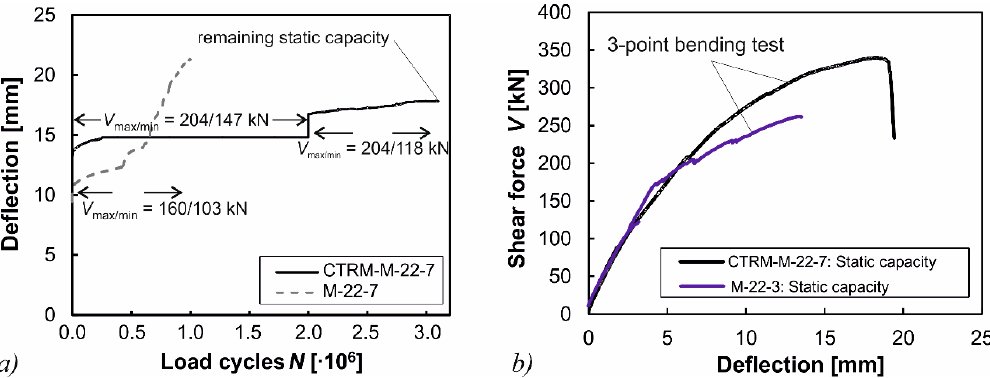
Figure 13. ( a ) Comparison of vertical deflections under cyclic loading for tests with shear reinforcement; and ( b ) the comparison of the remaining shear capacities of the non-strengthened and strengthened specimens.